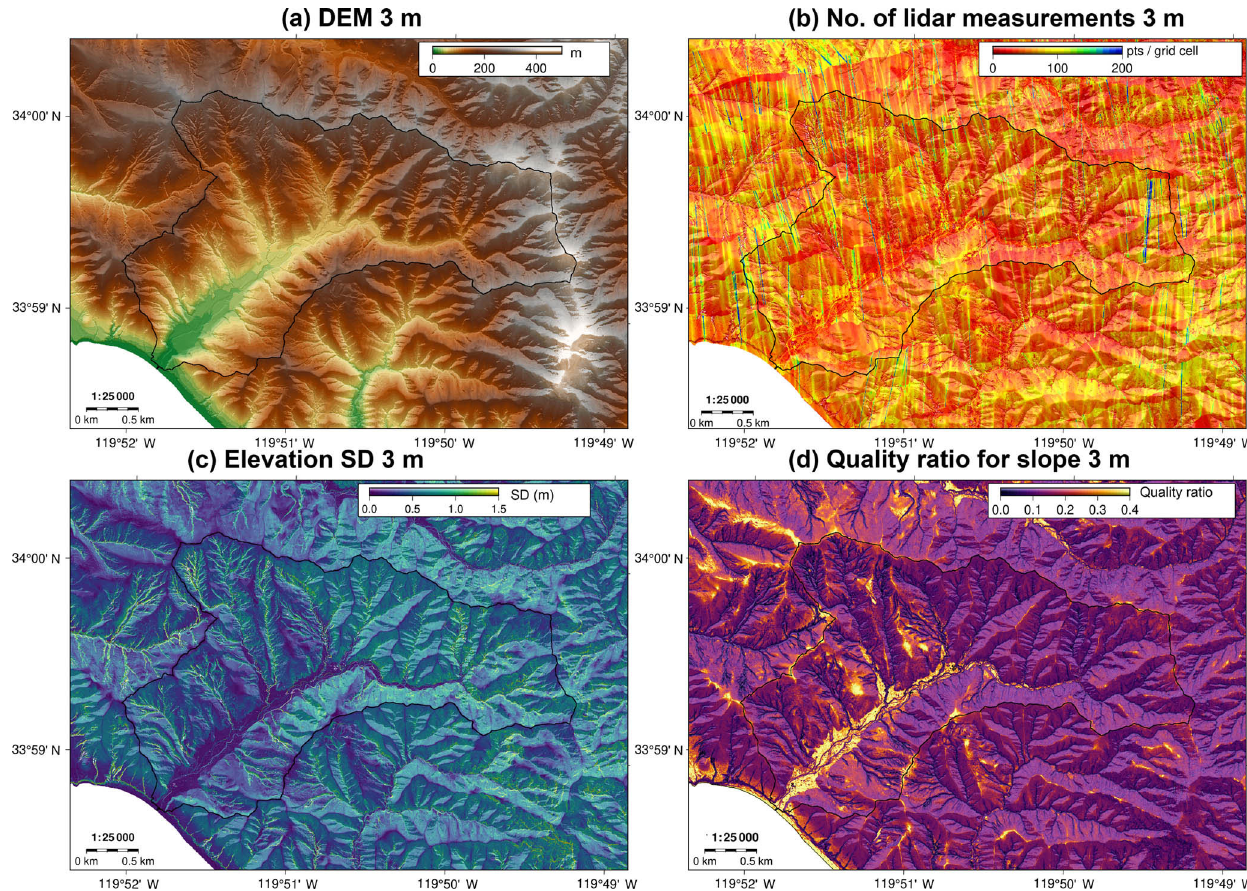
Figure 10. Selected metrics for the Pozo catchment in the southwestern part of SCI, calculated on the optimal grid resolution for this catchment (3m grid): (a) elevation, (b) lidar point density, (c) elevation standard deviation, and (d) slope quality ratio (see Eq. 14). The aspect quality ratio is shown in Fig. S26. A comparison of the elevation standard deviation and the lidar canopy height model is shown in Fig. S27.